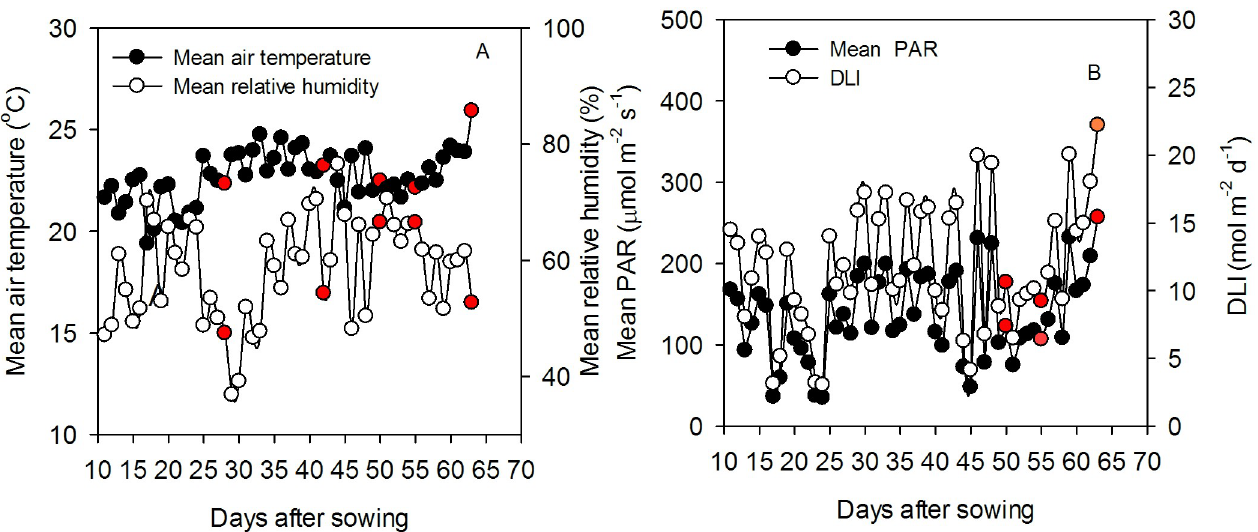
Fig 1. Weather variables during the growing period. (A) Mean air temperature and relative humidity. (B) Daily mean photosynthetically active radiation (PAR) and daily light (PAR) integral (DLI). The red spots in A correspond to the five days (28, 42, 50, 55, and 63 DAS) for the growth rate measurements and the red spots in B correspond to the three days (50, 55, and 63 DAS) for the photosynthetic light response and leaf trait measurements. DAS denotes days after sowing.